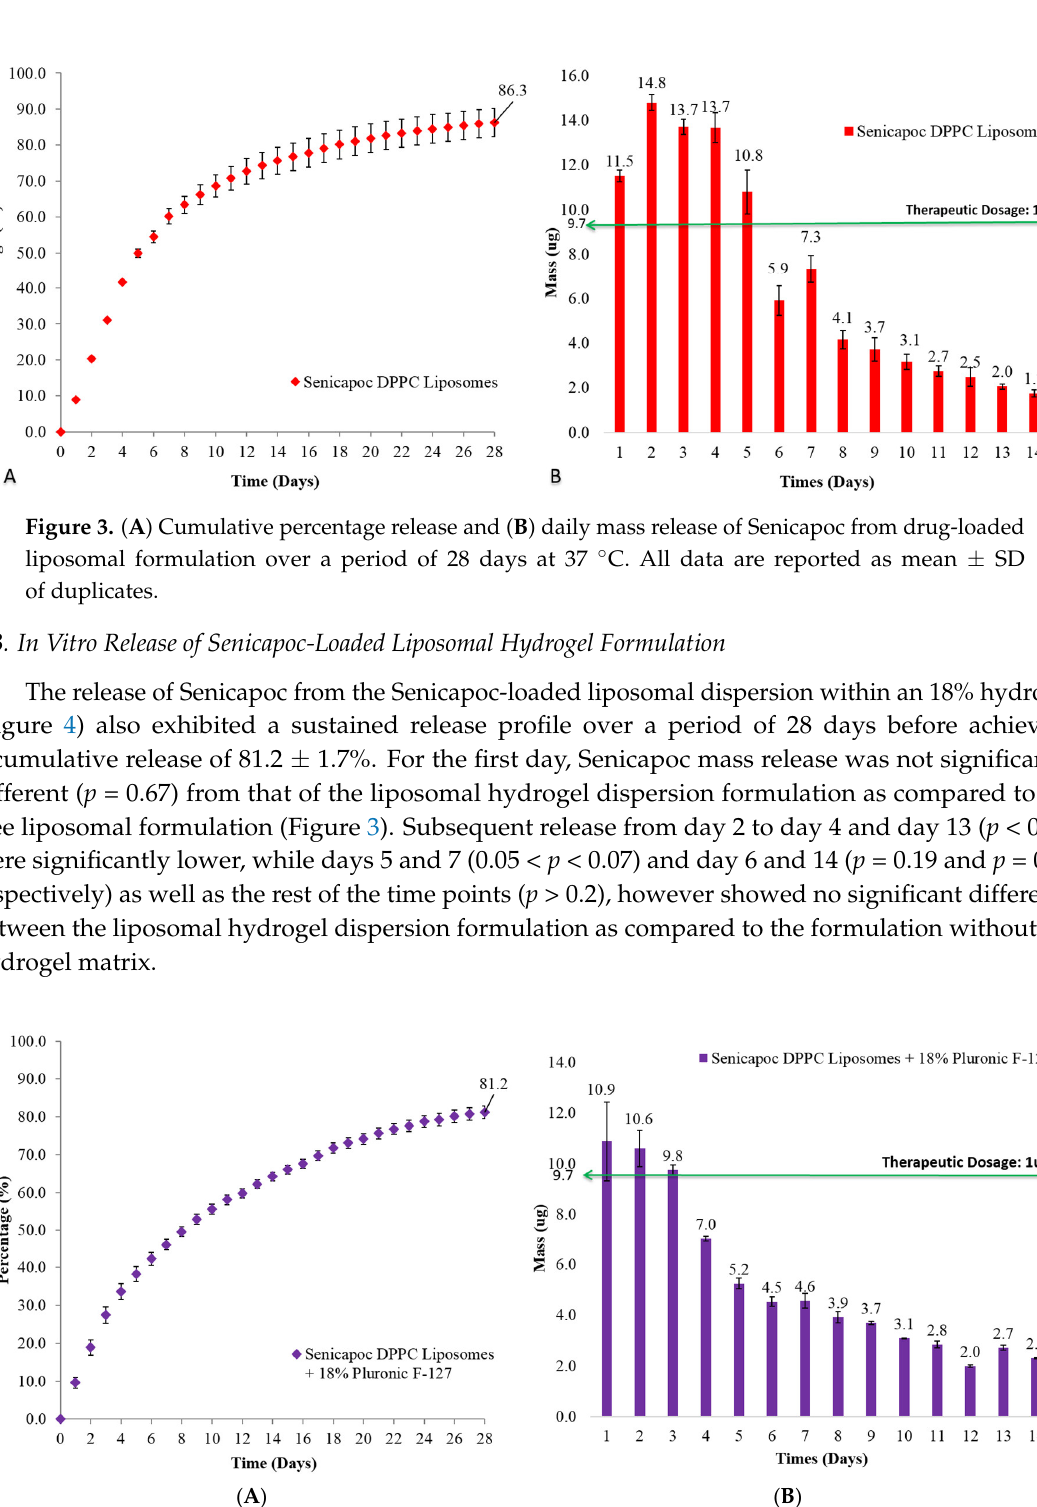
Figure 4. ( A ) Cumulative percentage release and ( B ) daily mass release of Senicapoc from drug- loaded liposomes dispersed in 18% hydrogel formulation over a period of 28 days at 37 °C. All data are reported as mean ± SD of duplicates.